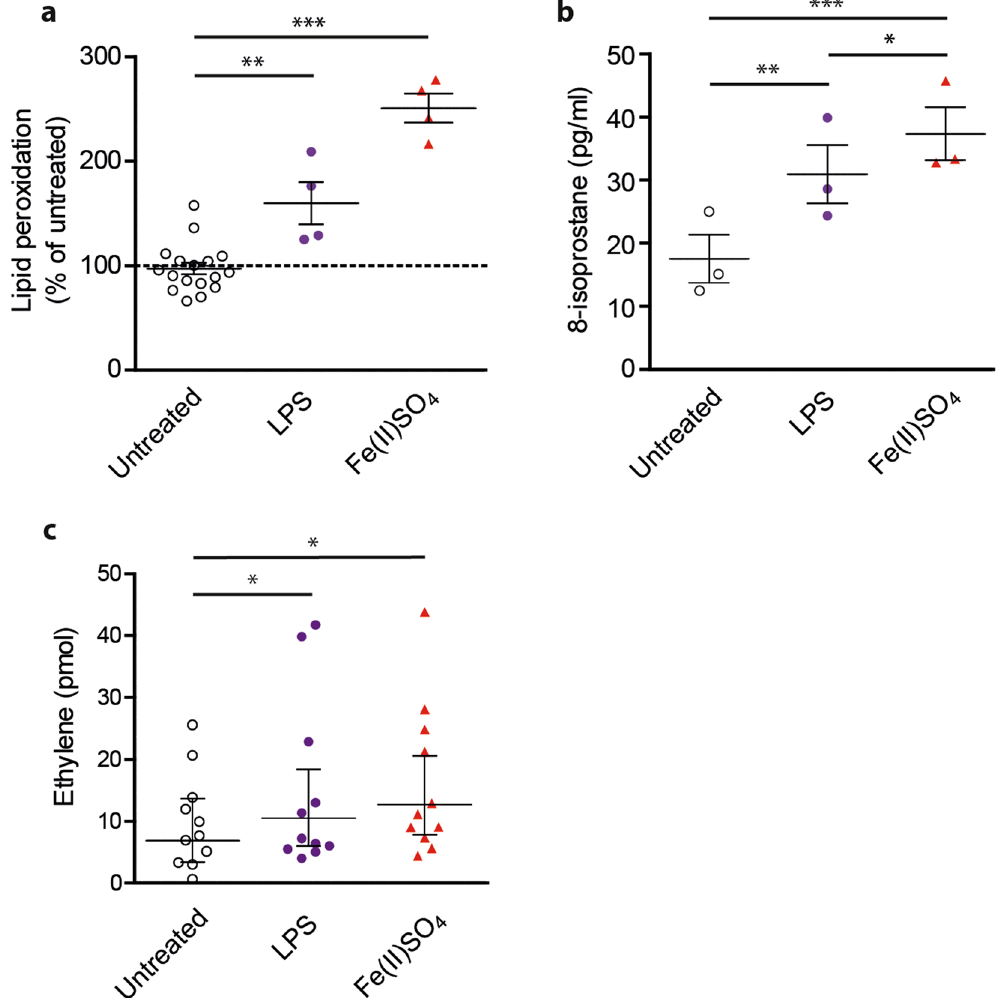
Figure 2. LPS triggers lipid peroxidation and ethylene formation in leukocytes. ( a ) Lipid peroxidation in moDCs as measured by blue-shift of Bodipy581/591-C11 fluorescence. MoDCs were treated with 1 µ g/ml LPS or 100 µ M Fe(II)SO 4 (n = 4). (b) Lipid peroxidation in moDCs measured by EIA assay for 8-isoprostane. Cells were treated with either LPS or 100 µ M Fe(II)SO 4 in serum-free RPMI-1640 (n = 3). (c) Total ethylene released during 1 hour stimulation of leukocytes with either 1 µ g/ml LPS or 100 µ M Fe(II)SO 4 , as detected by laser-based photoacoustic spectroscopy (n = 11). Data points show mean with SEM (panels a and b) or geometric mean with 95% CI (panel c), asterisks indicate significance compared to untreated